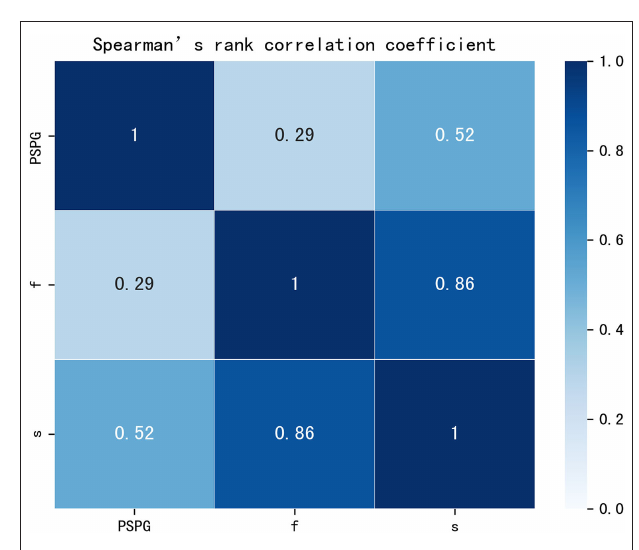
FIGURE 4 | Rank correlation matrix among PSPG, f, and s. PSPG, f, and s were all positively correlated ( p < 0.05). Lighter shades of blue correspond to lower correlation coefficients that the darker shades. PSPG, peak systolic pressure gradient; f, viscous friction in Equation 1; s, expansion loss in Equation